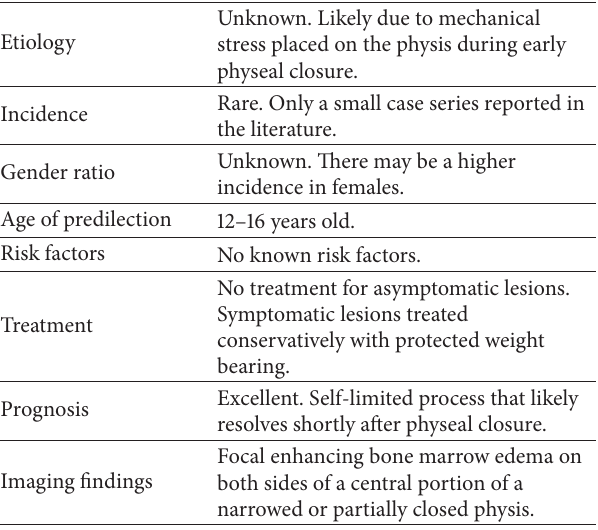
Table 1: FOPE zone clinical